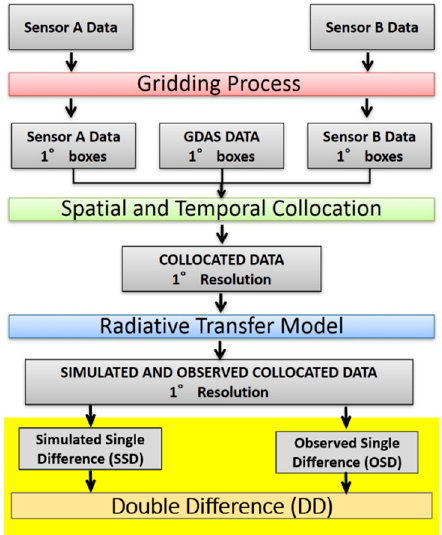
Figure 1. Block diagram of the normalization process in the Central Florida Remote Sensing Lab (CFRSL) Intercalibration (XCAL) Algorithm. The National Oceanic and Atmospheric Administration (NOAA) Global Data Assimilation System (GDAS), using the NCEP Global Forecast System (GFS) model (NCEP 2000), provides geophysical parameters at 00:00, 06:00, 12:00, and 18:00 Universal Coordinated Time (UTC), on a 1 ◦ × 1 ◦ latitude / longitude